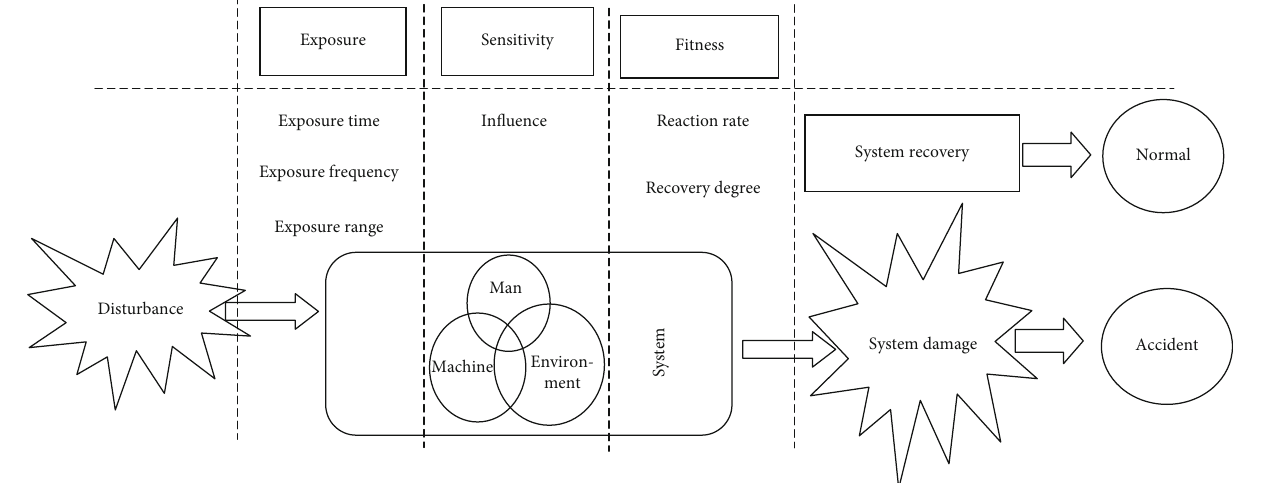
Figure 1: Vulnerability characteristic element evolution